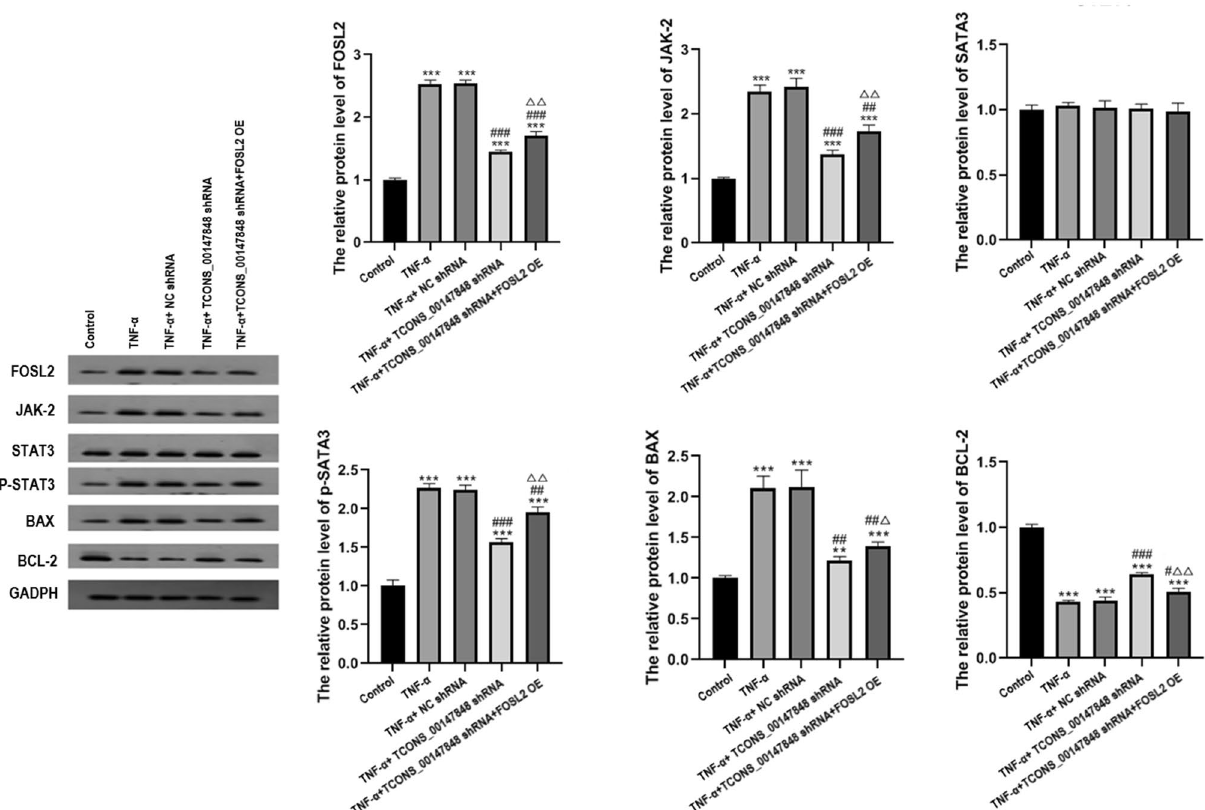
Figure 8. TCONS_00147848 and FOSL2 regulated expressions of FOSL2, JNK-2, STAT3, P-STAT3, BAX, and BCL-2 in nasal mucosa cells of mice treated with TNF-α detected by Western blot. ** P < 0.01 vs. Control group, *** P < 0.001 vs. Control group, # P < 0.05 vs. AR group, ## P < 0.01 vs. AR group, ### P < 0.001 vs. AR group, △ P < 0.05 vs. TNF-α + TCONS_00147848 shRNA group, △△ P < 0.01 vs. TNF-α + TCONS_00147848 shRNA group (Software version: SPSS 23.0; URL: https:// www. ibm. com/ legal/ copyt rade.